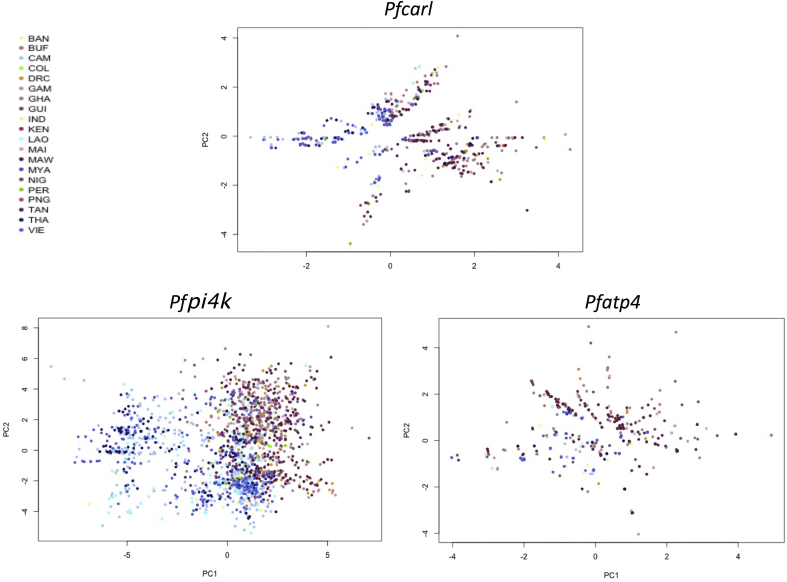
Population structure at a continental level for the Pfcarl, Pfpi4k and Pfatp4 genes. Principal Components (PC) Analysis plot (x axis represents PC1, and y axis PC2) on the ∼2000 P. falciparum field samples from 18 countries for each gene.